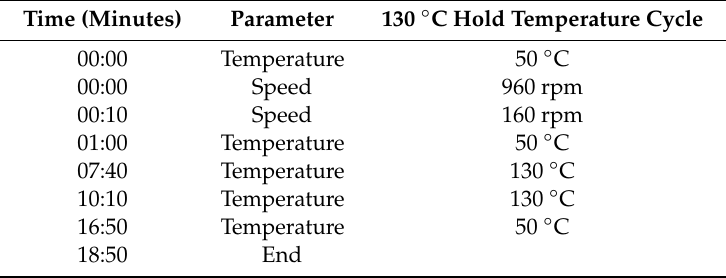
Table 1. Standard pasting profile at 130 ◦ C used for measuring pasting properties of whole bean flours (adapted from Perten Instruments,